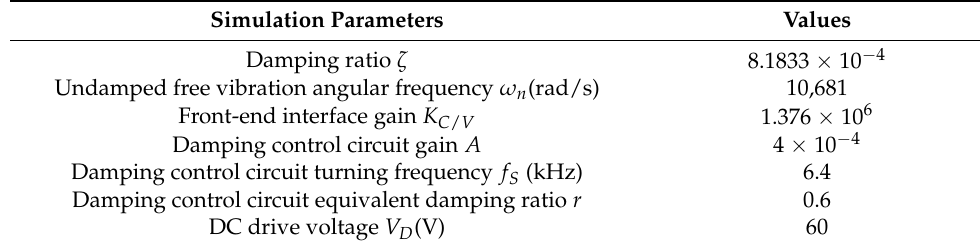
Figure 9. Simulink model of the electrostatic active damping closed-loop control. Table 2. Simulation parameters and their values.